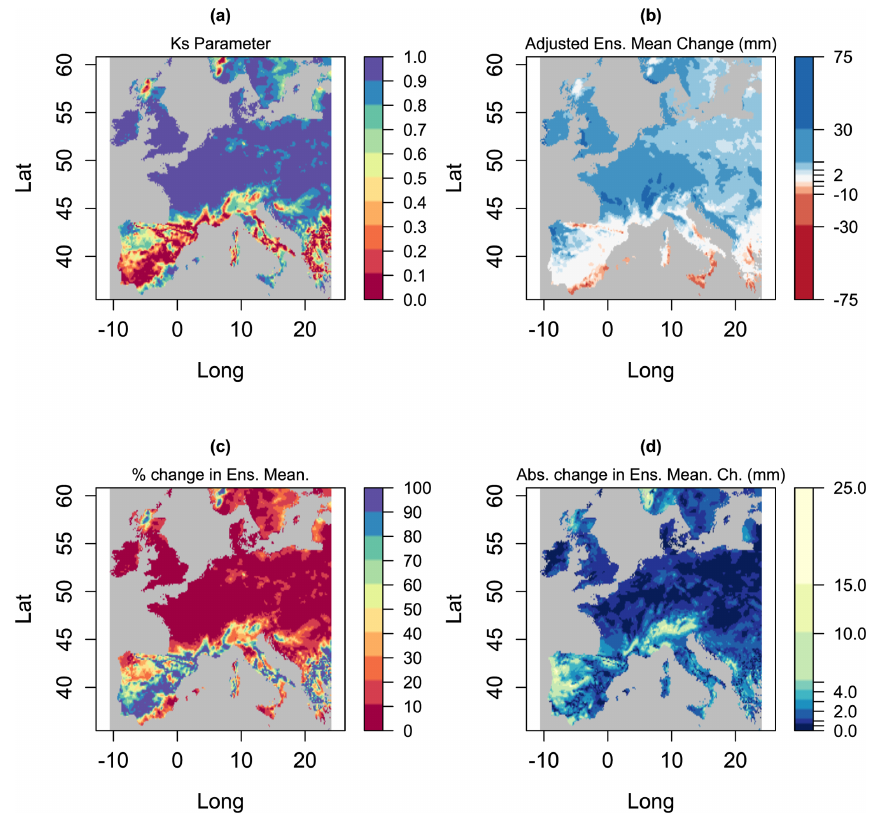
Figure 4. Various metrics derived from the EURO-CORDEX data shown in Fig. 1. Panel (a) shows the reduction parameter ˆ k s for the SPMA method, panel (b) shows the ensemble mean reduced by the parameter ˆ k s , panel (c) shows the percent change in the ensemble mean from applying SPMA, and panel (d) shows the absolute (unsigned)